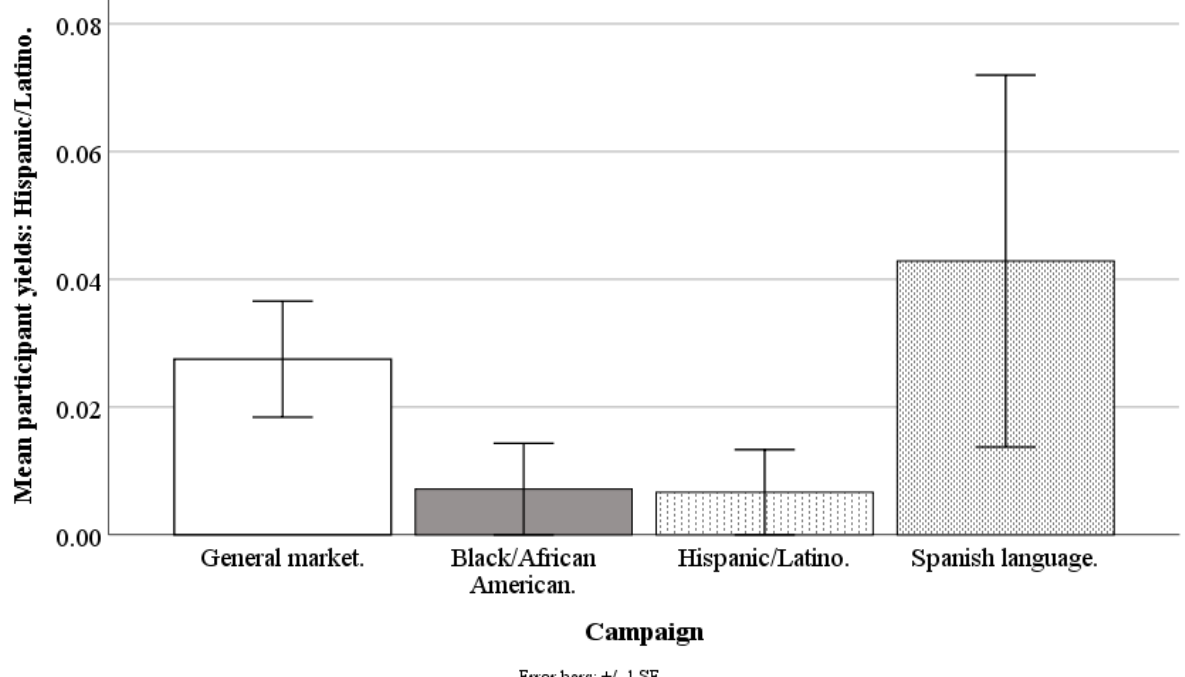
Figure 9. Mean participant yields of Hispanics/Latinos for Facebook advertising